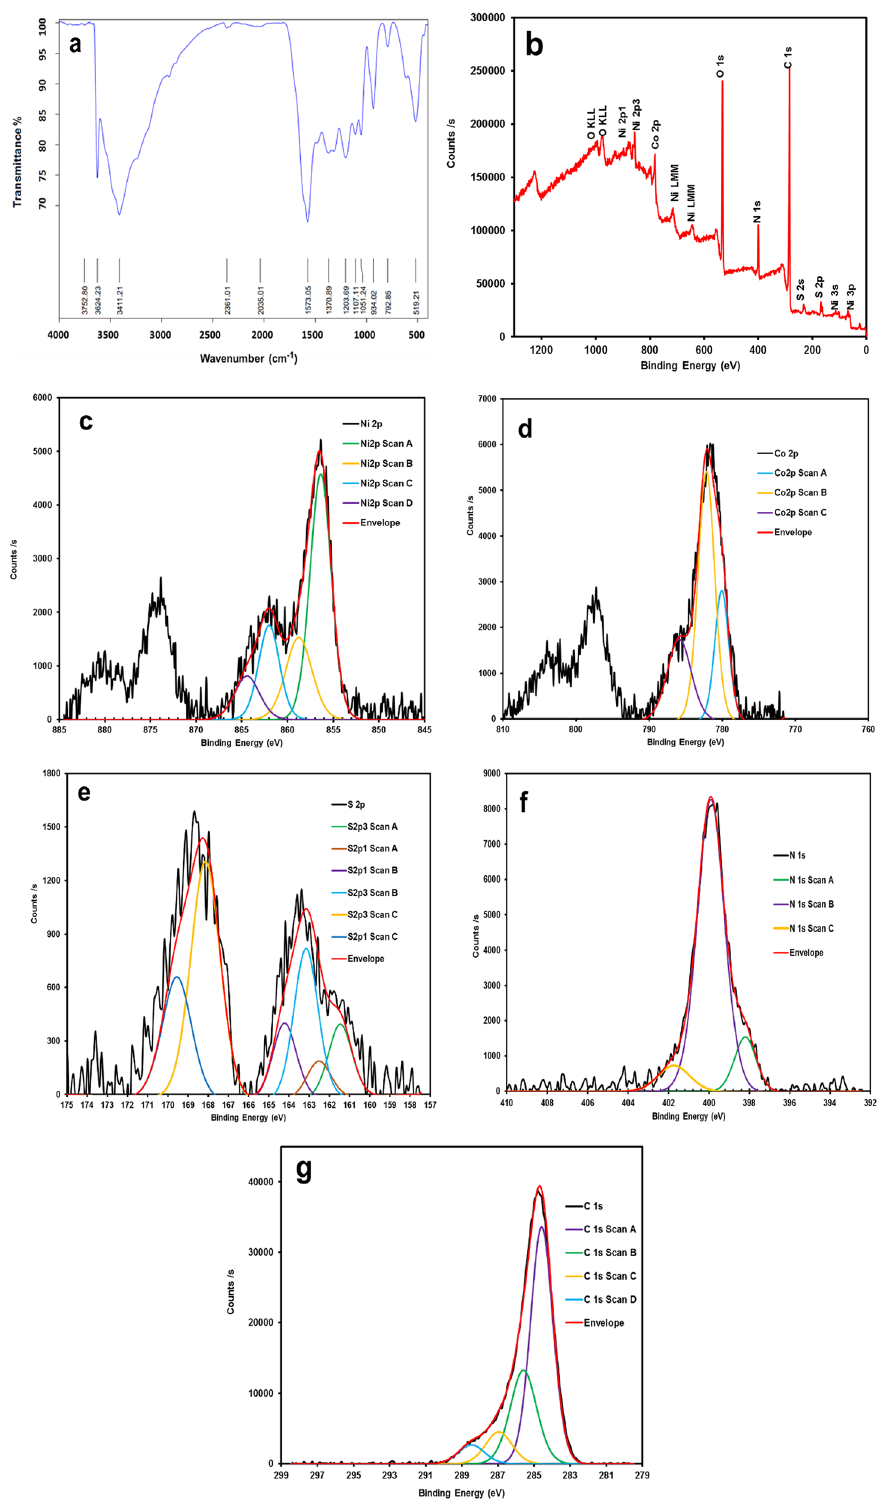
Figure 5. ( a ) FT-IR spectrum, ( b ) XPS survey, and ( c – g ) XPS spectra of Ni 2p, Co 2p, S 2p, N 1 s, and C 1 s for the